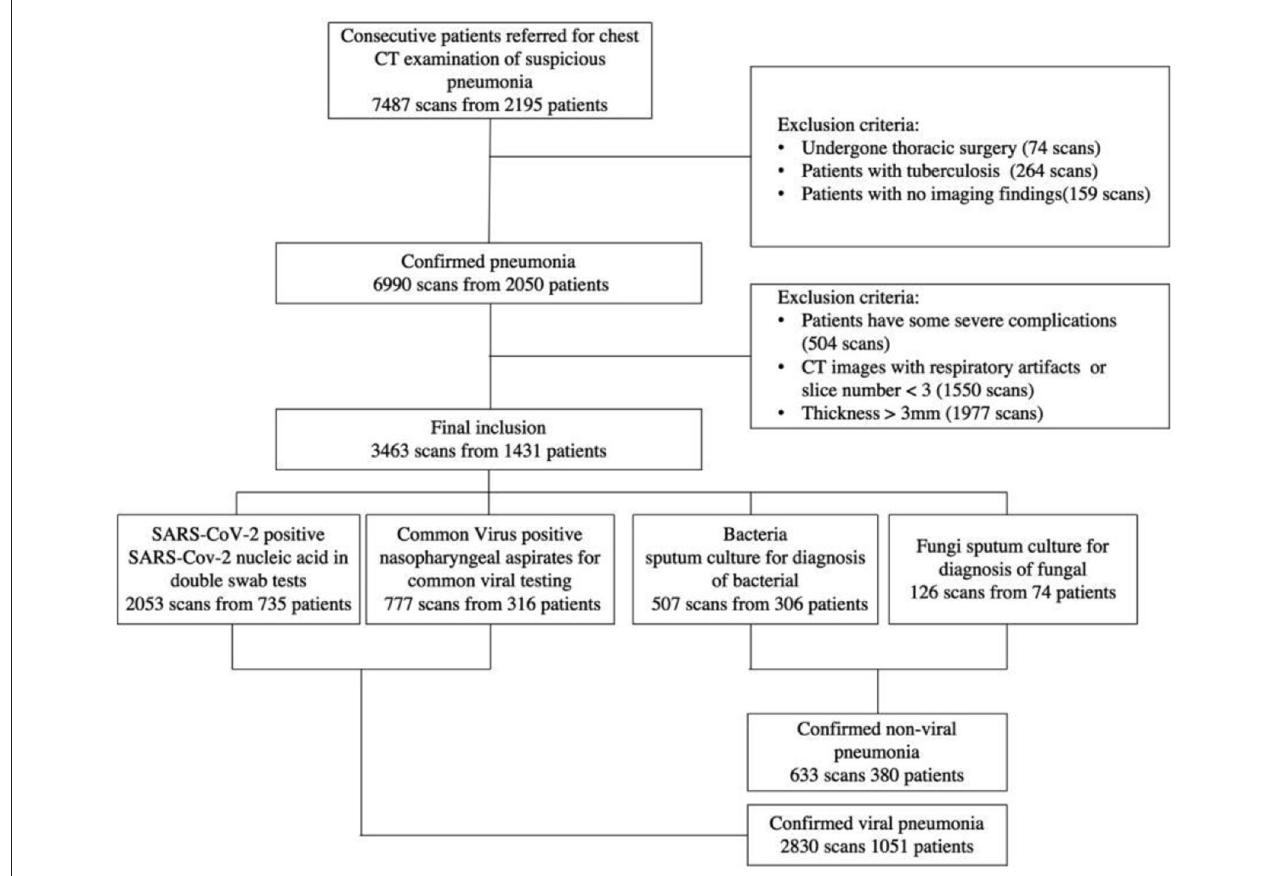
FIGURE 1 | A flow diagram of the patient selection process with inclusion and exclusion criteria is shown. Between January 2011 and February 2020, this study included 2,195 patients from three institutions, 1,431 of whom were finally used to construct the classification system.